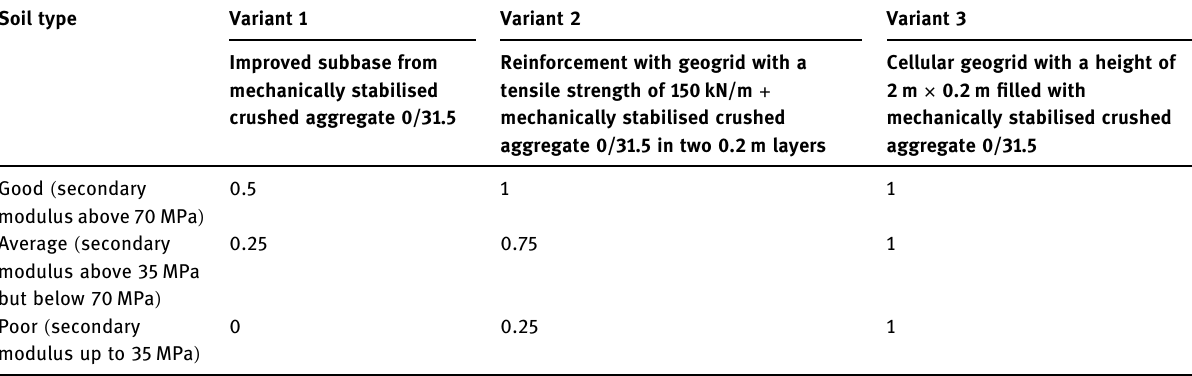
Table 1: Probability of soil strengthening variant ’ s e ff ectiveness depending on soil type ( empirical data – an analogy to the project of the restoration of the outer courtyard and its access routes at the Royal Castle at Wawel Hill